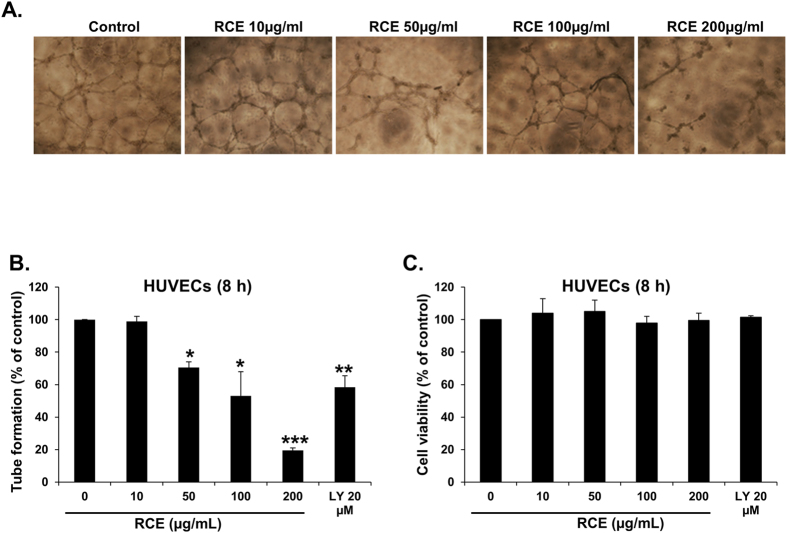
Effect of Rhus coriaria on the formation of capillary-like structures by HUVECs in vitro.(A) Patterns of angiogenesis induced by human umbilical vein endothelial cells (HUVECs) cultured on Matrigel matrix in 96-well plates with or without RCE. (B) Quantification of tubular morphogenesis induced in HUVECs cells cultured with or without RCE. Tube formation was determined by the length of tube-like structures containing connected cells. LY (20 μM) was used as positive controls for angiogenesis inhibition in this assay. Data are mean ± S.E.M. from three independent experiments. Statistical analysis was performed using one-way ANOVA (*p < 0.05, **p < 0.005, ***p < 0.001). (C) Effect of RCE on cell viability of HUVECs. Viable cells were assayed as described in Materials and Methods. Columns represents mean; bars represents SEM.